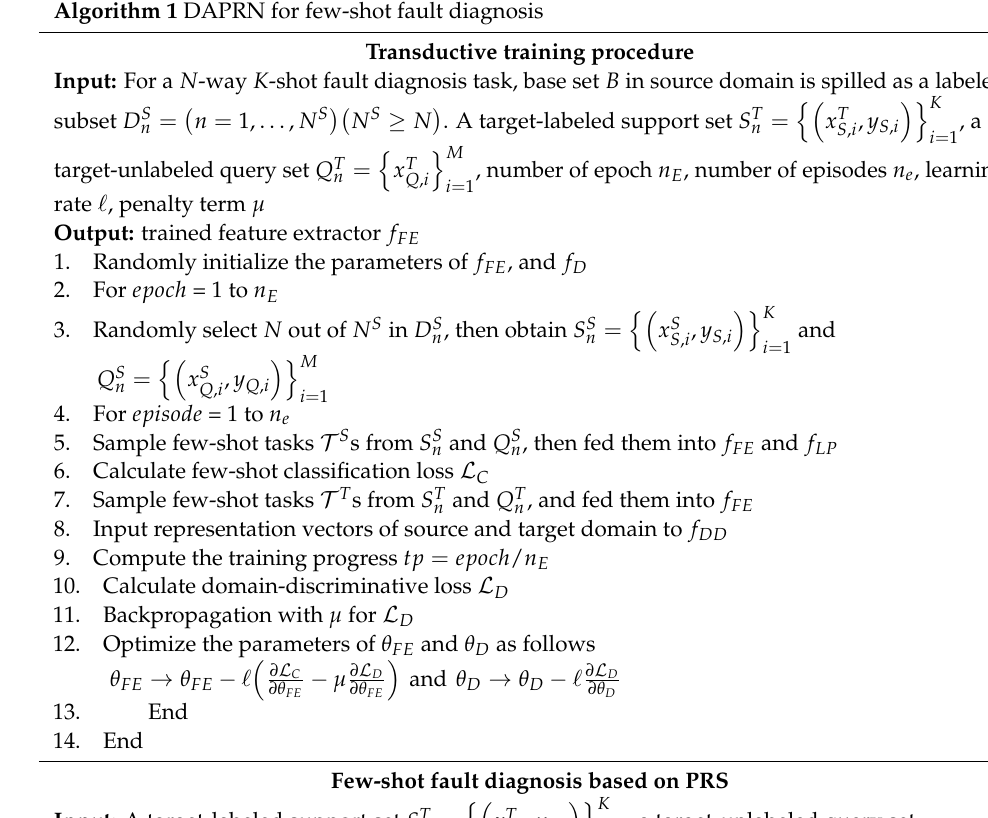
Algorithm 1 DAPRN for few-shot fault diagnosis Transductive training